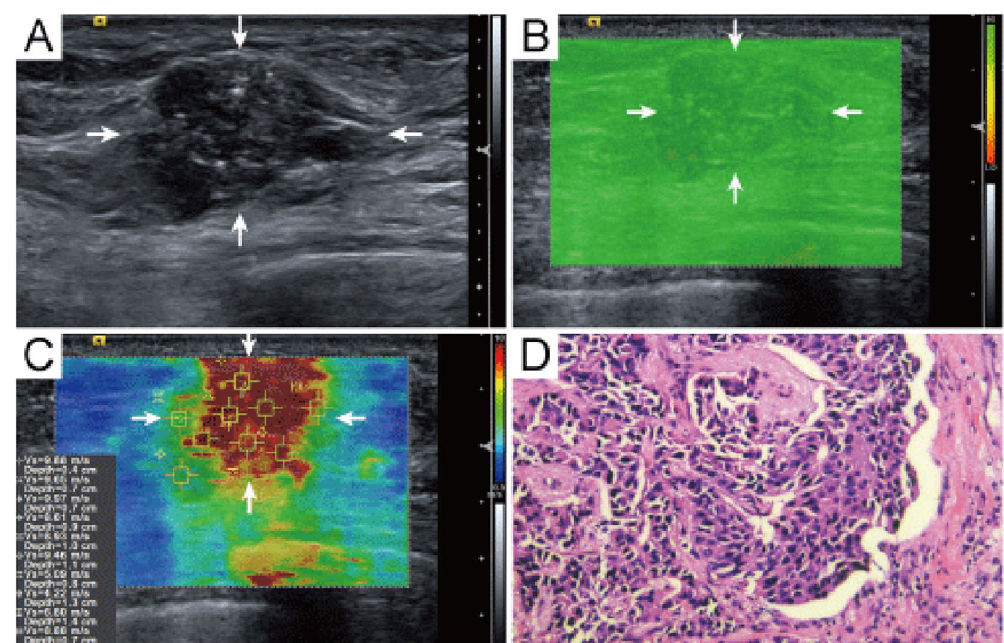
Figure 3. Invasive ductal carcinoma in a 70 years old woman. ( A ) The lesion (arrows) is classified as US BI- RADS category 5 on B-mode US. ( B ) The whole lesion (arrows) is covered by green color on QM mode of SWS imaging, indicating high QM, although calcifications are observed. ( C ) The SWSmax of the lesion (arrows) is 9.88 m/sec. ( D ) Pathological examination confirms the diagnosis of invasive ductal carcinoma (hematoxylin- eosin stain; original magnification, 200). QM = quality